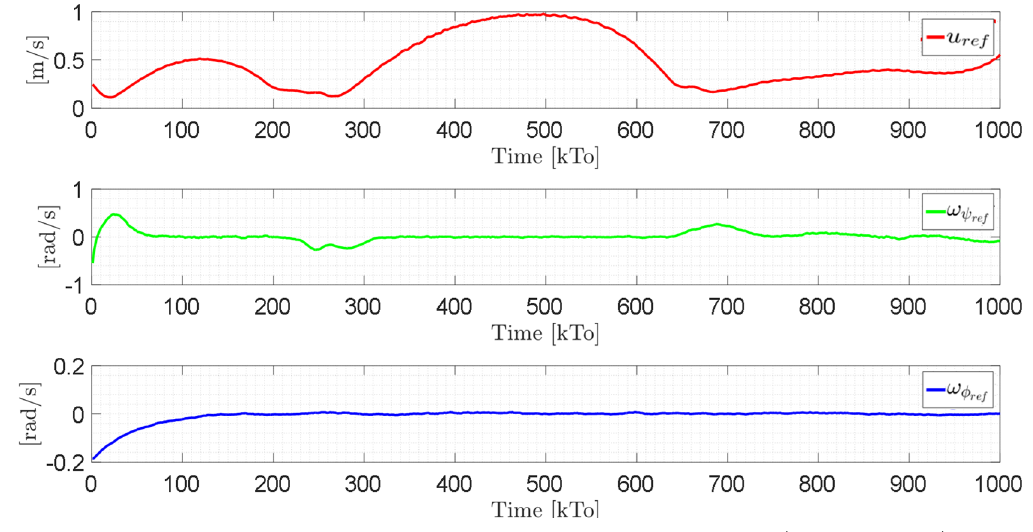
(cid:16) (cid:17) ( ) u ref , ω ψ , ω φ . ( ) , ref ref 0 (cid:0) (cid:1) ∈ R 3 converge to values close (cid:101) η x , (cid:101) η y , (cid:101) η z